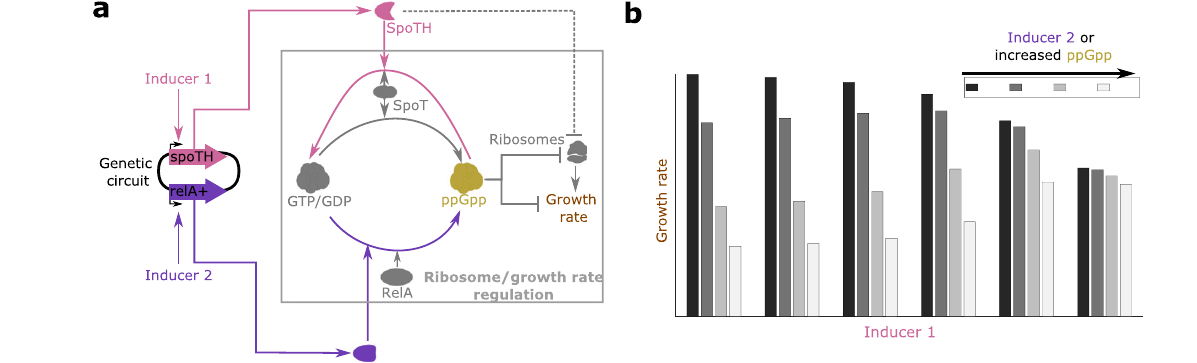
RelA+ are expressed by a synthetic genetic circuit and are under the control of inducible promoters. The dashed fl at headed arrow from SpoTH to ribosomes represents the load SpoTH expression places on ribosomes as its mRNA is trans- lated. b Growth rate as a function of SpoTH level (inducer 1) for varying ppGpp concentration (different shades of gray). RelA+ (inducer 2) expression increases ppGpplevelandthusdecreasesgrowthrate.SeeSupplementarynotes2and3fora mathematical